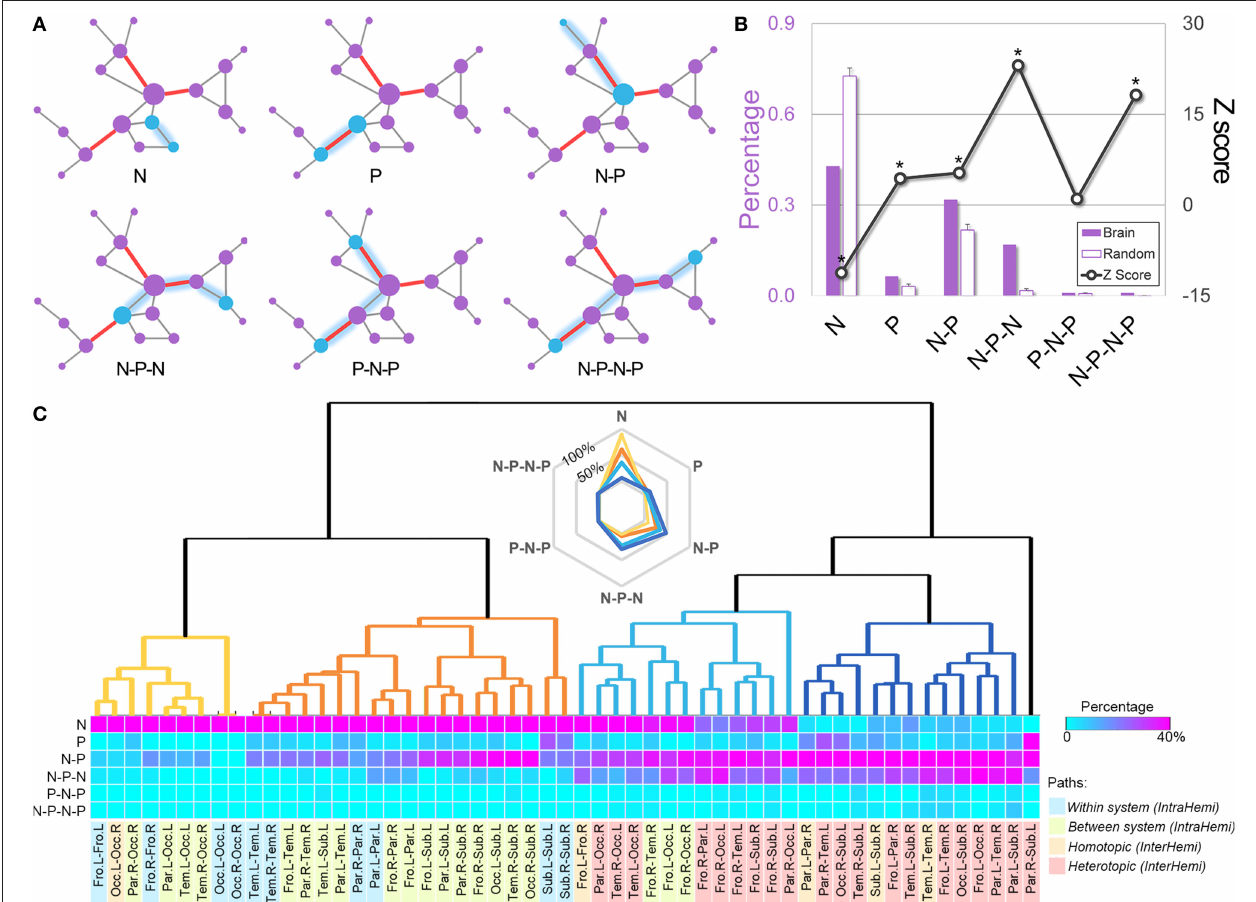
FIGURE 5 | Path motifs of the whole-brain WM network and of different brain systems. (A) Examples of the six types of path motifs in the whole-brain WM network. Path motifs were defined as the ordered sequence of the pivotal or the non-pivotal edges on the routes of each shortest path. N, non-pivotal edge; P, pivotal edge. (B) The frequency percentage and normalized distribution of path motifs derived by comparing the actual frequency of each path motif to that of 1000 equivalent random networks. The “non-pivotal to pivotal to non-pivotal” (N-P-N) path motif was the most frequent path motif in the brain network ( Z bottom matrix shows the proportions of path motifs between each pair of the brain systems. The following hierarchical clustering analysis revealed four path-motif distribution patterns, of which the path motif “N” decreased gradually while the “P” related path motifs constantly accumulated. Notably, most within-system and intra hemispheric paths communicated with the style “N,” while the inter-hemispheric paths, especially paths between heterotopic systems, utilized the pivotal edges more often. Fro, frontal; L, left; Occ, occipital; R, right; Par, parietal; Tem, temporal; Sub, subcortical; IntraHemi, intra hemispheric; InterHemi, inter hemispheric.